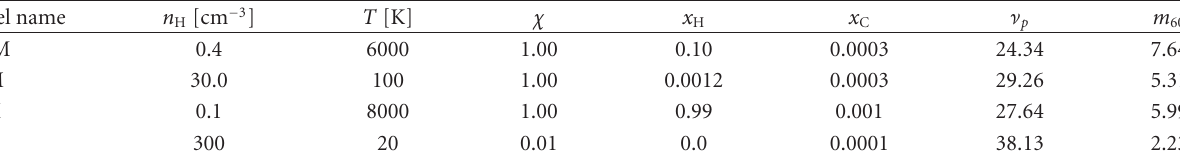
Table 1: Parameters for the spectra in Figure 2. The SpDust input parameters are as follows: the total hydrogen number density n H , the gas temperature T , the intensity of the radiation field relative to the average interstellar radiation field χ , the hydrogen ionization fraction /n x = n H H , and the ionized carbon fractional abundance H +